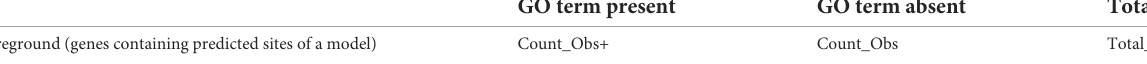
TABLE 1 2 × 2 contingency table explaining GO enrichment analysis.